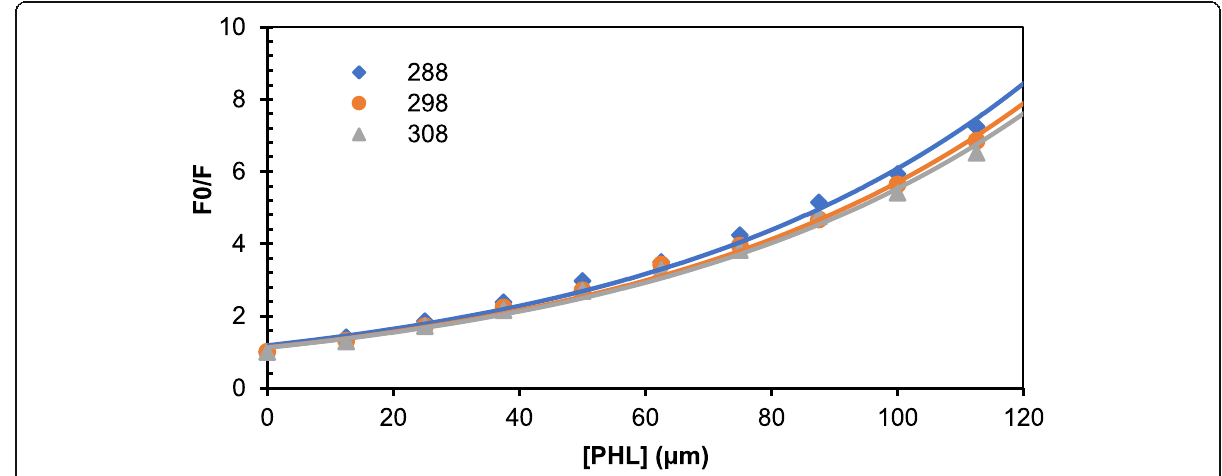
Fig. 9 The Stern-Volmer linear of PHL vs. INS under three different temperature conditions